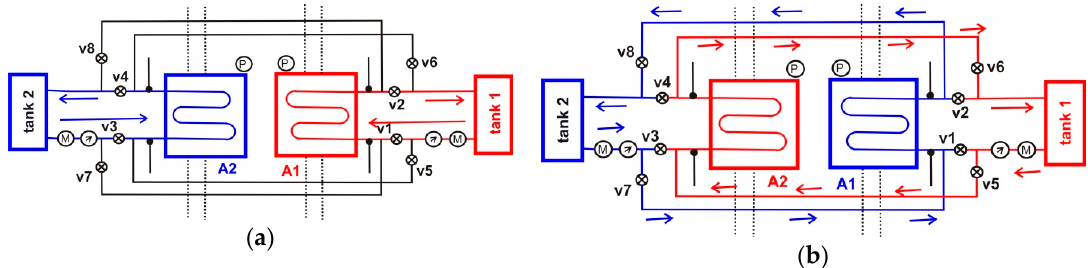
Figure 3. Scheme of thermal liquid flow during the first ( a ) and second ( b ) half-cycles, according to the working diagram (Table 1). Tank 1 is maintained at T = T H and tank 2 at T = T M